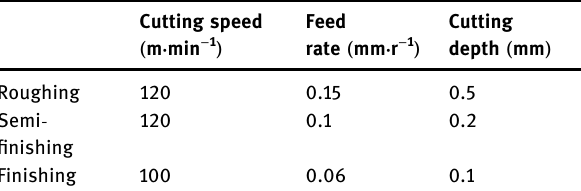
Table 4: Machining parameters of thin - walled